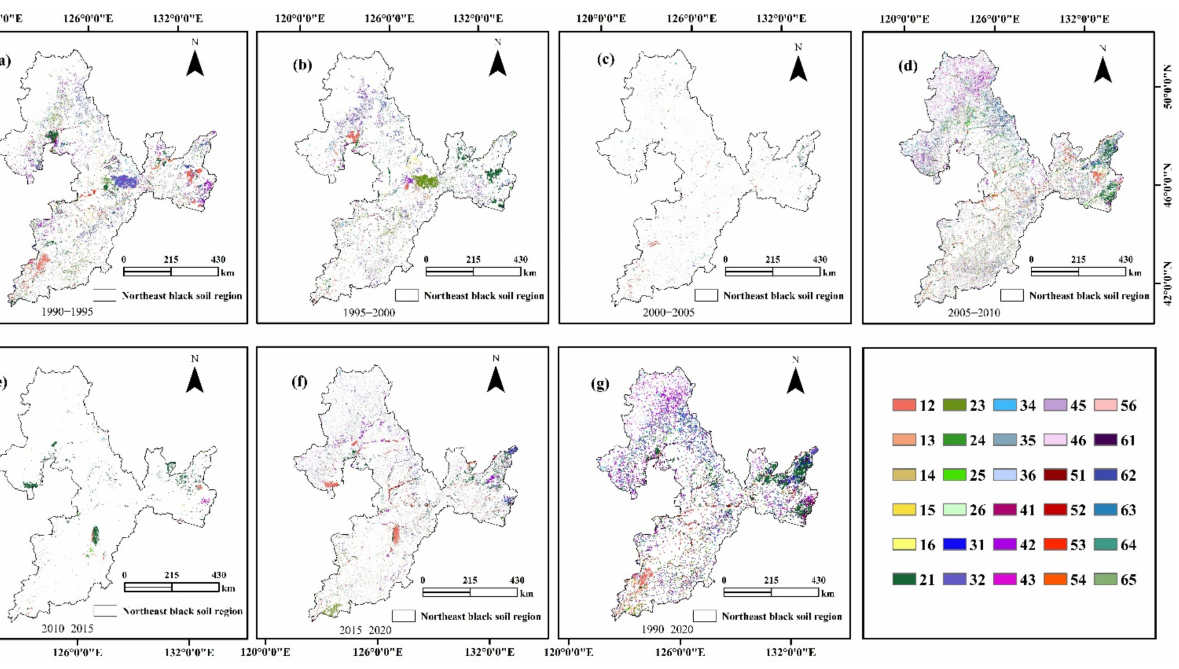
Figure 3. Spatial distribution of land-use transfer in the BSRNC from 1990 to 2020. Notes: 1: Paddy; 2: dry land; 3: forest; 4: grassland; 5: water area; 6: unused land. ( a ) is the spatial distribution of land-use transfer in the BSRNC from 1990 to 1995; ( b ) is the spatial distribution of land-use transfer in the BSRNC from 1995 to 2000; ( c ) is the spatial distribution of land-use transfer in the BSRNC from 2000 to 2005; ( d ) is the spatial distribution of land-use transfer in the BSRNC from 2005 to 2010; ( e ) is the spatial distribution of land-use transfer in the BSRNC from 2010 to 2015; ( f ) is the spatial distribution of land-use transfer in the BSRNC from 2015 to 2020; ( g ) is the spatial distribution of land-use transfer in the BSRNC from 1990 to